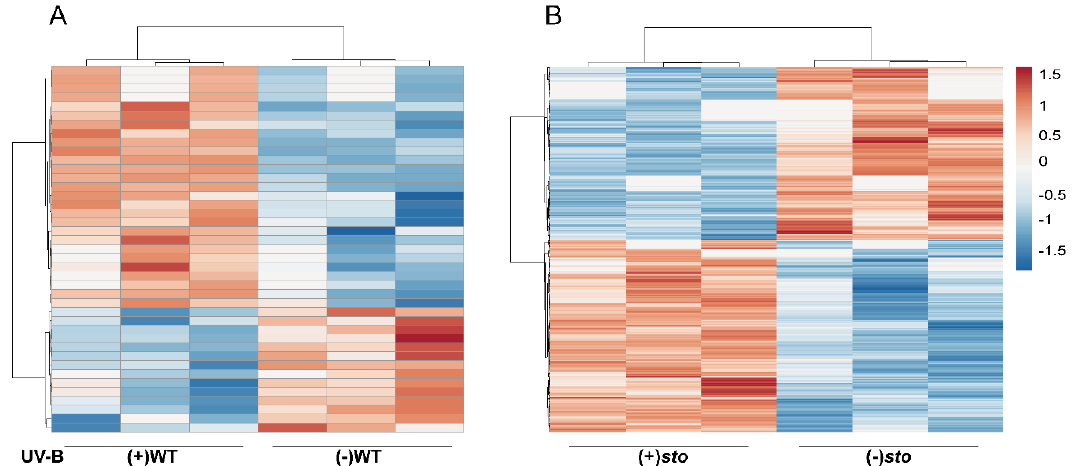
Figure 1. Clustering analysis of the di ff erentially expressed proteins. ( A ) A hierarchical clustering analysis of the di ff erentially expressed proteins in the wild-type (WT) seedlings with ( + ) or without (-) UV-B radiation. ( B ) A hierarchical clustering analysis of the di ff erentially expressed proteins in the sto seedlings with ( + ) or without (-) UV-B. The bar represents the log 2 fold change value. Table 2. Number of differentially expressed proteins in each comparison group.